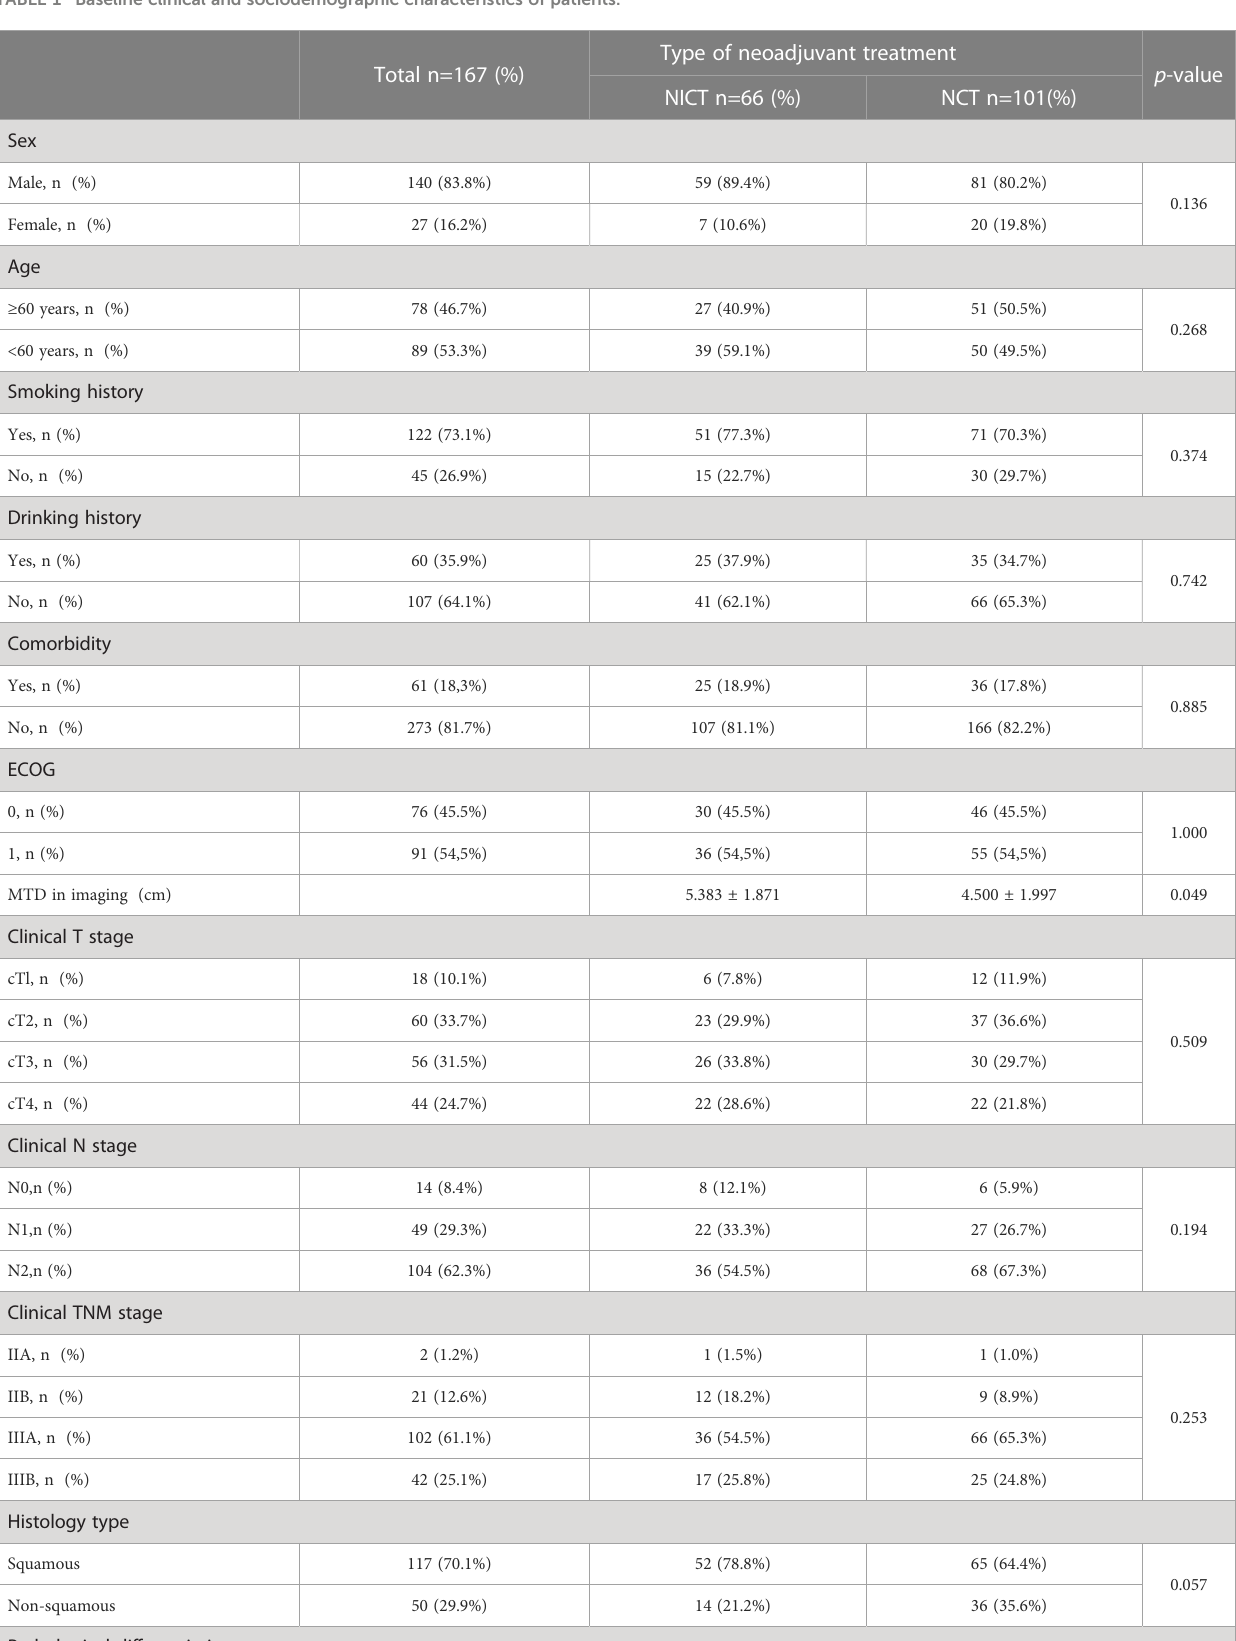
TABLE 1 Baseline clinical and sociodemographic characteristics of